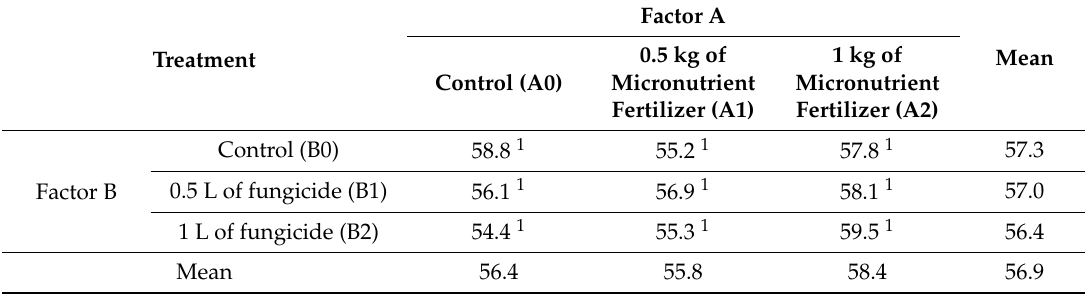
Table 6. E ff ect of di ff erent combinations of the micronutrient fertilizer and fungicide doses on Pieper’s germination time